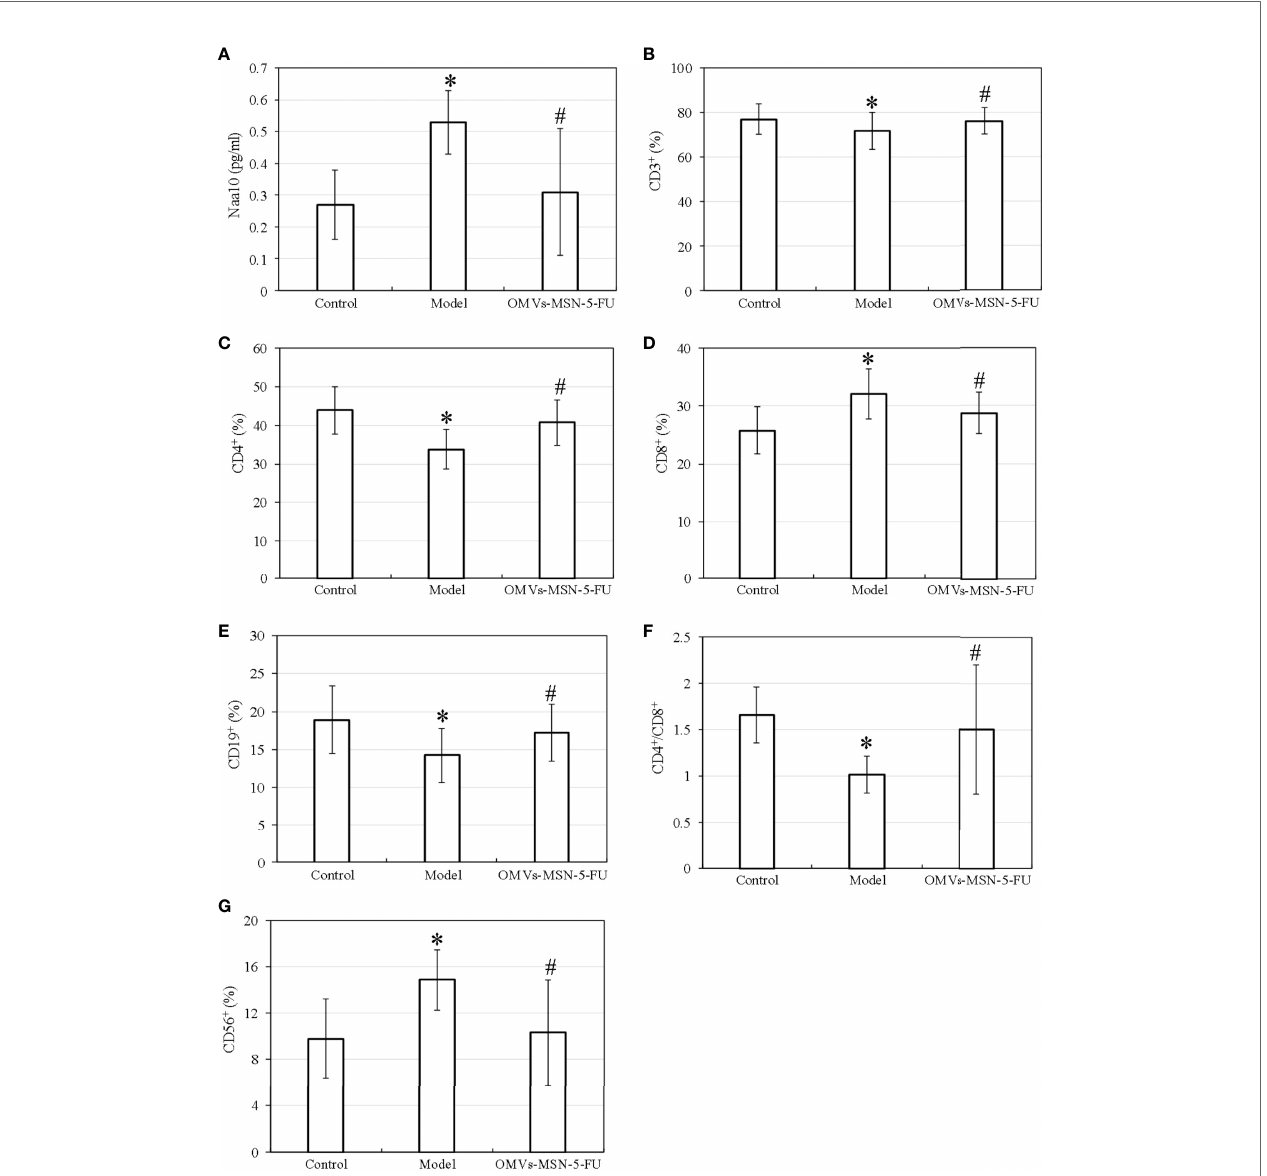
FIGURE 9 | Differences in the levels of Naa10 and lymphocyte subgroups in peripheral blood. (A) was Naa10; (B) was CD3 + level; (C) was CD4 + ; (D) was CD8 + ; (E) was CD19 + ; (F) was CD4 + /CD8 + ratio; (G) was CD56 + ; compared to the control group, * P< 0.05; compared to the model group, # P<